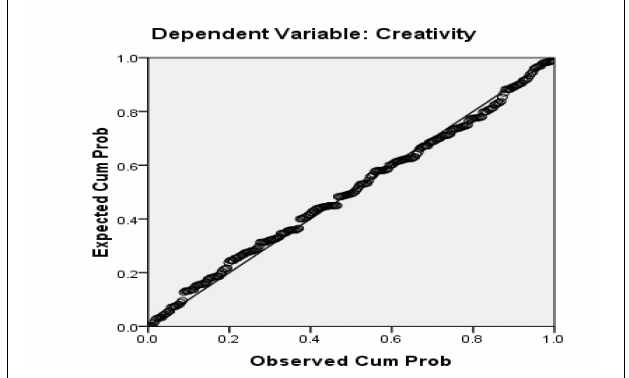
FIGURE 6 | Normal Probability Plot (p-p) of the Regression Standardized Residuals (independent variable = grit and dependent variable = creativity).